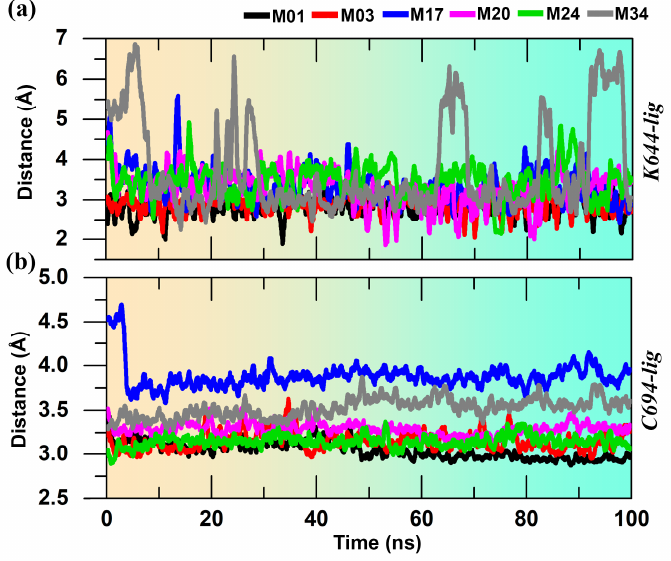
Figure 4. H-bond interaction distance analysis from ( a ) residue K644 and ( b ) C694 to the ligands during the production simulation.